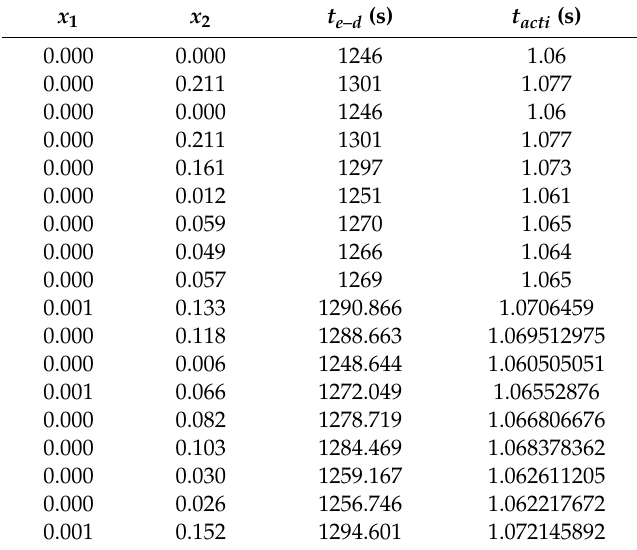
Table 3. The structural parameters corresponding to noninferior solutions.